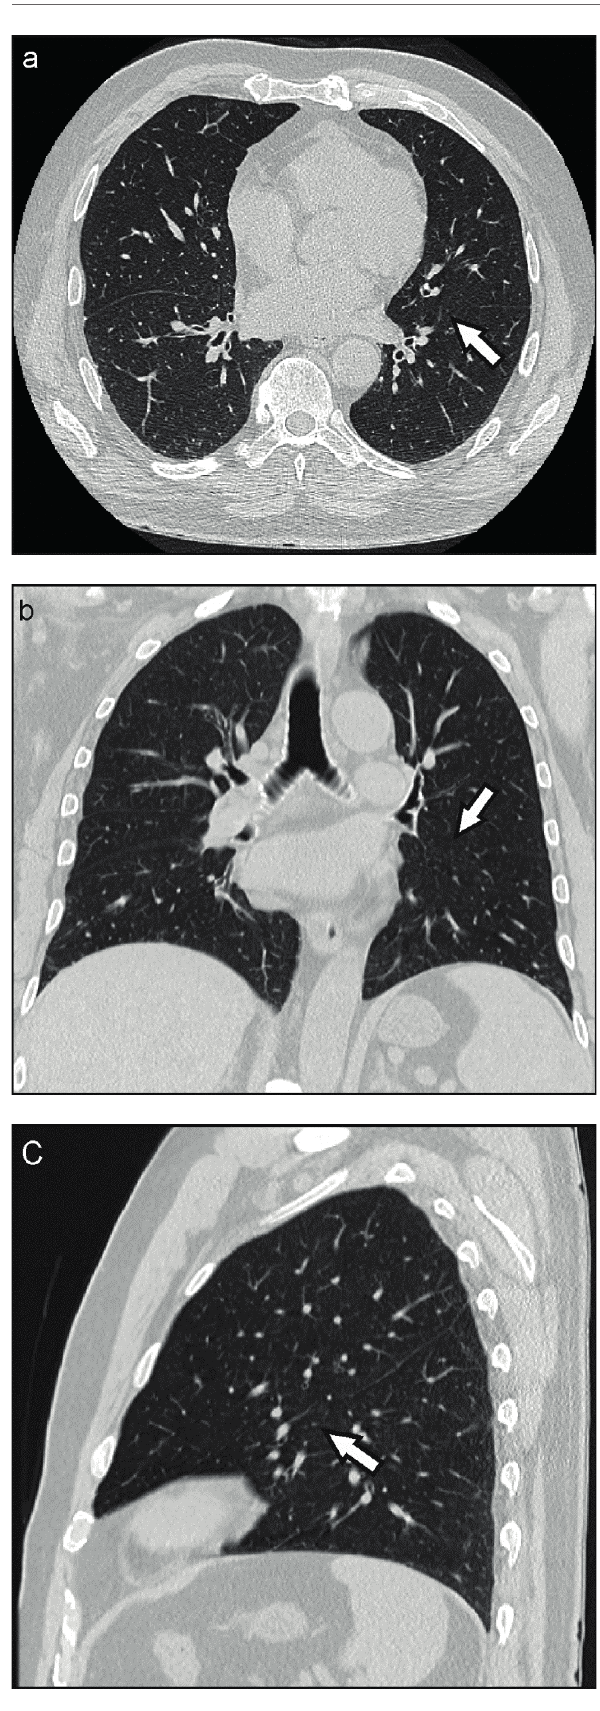
tions showing the incomplete left oblique fissure with parahilar disconnection